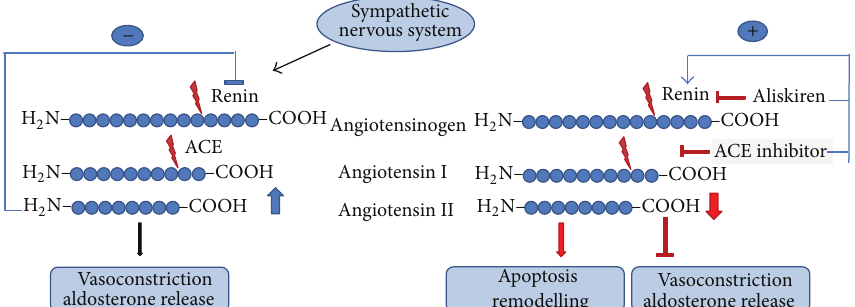
Figure 1: Coupling of sympathetic nervous system (SNS) to the renin-angiotensin system. Activation of the SNS increases the release of renin that formsangiotensin I fromangiotensinogen. Angiotensin I isfurther converted toangiotensin IIby angiotensin-converting enzyme (ACE). Angiotensin II is the effector molecule triggering the known effects of angiotensin II aimed to increase blood pressure. Via its inhibition on renin release it also possesses a feedback loop (left side). Inhibition of the RAAS by either ACE inhibition, AT receptor antagonism, or direct renin inhibition increases the release of renin but lowers the concentration of angiotensin II. Thereby, it reduces AT receptor-dependent effects but exerts new effects linked to remodelling (right